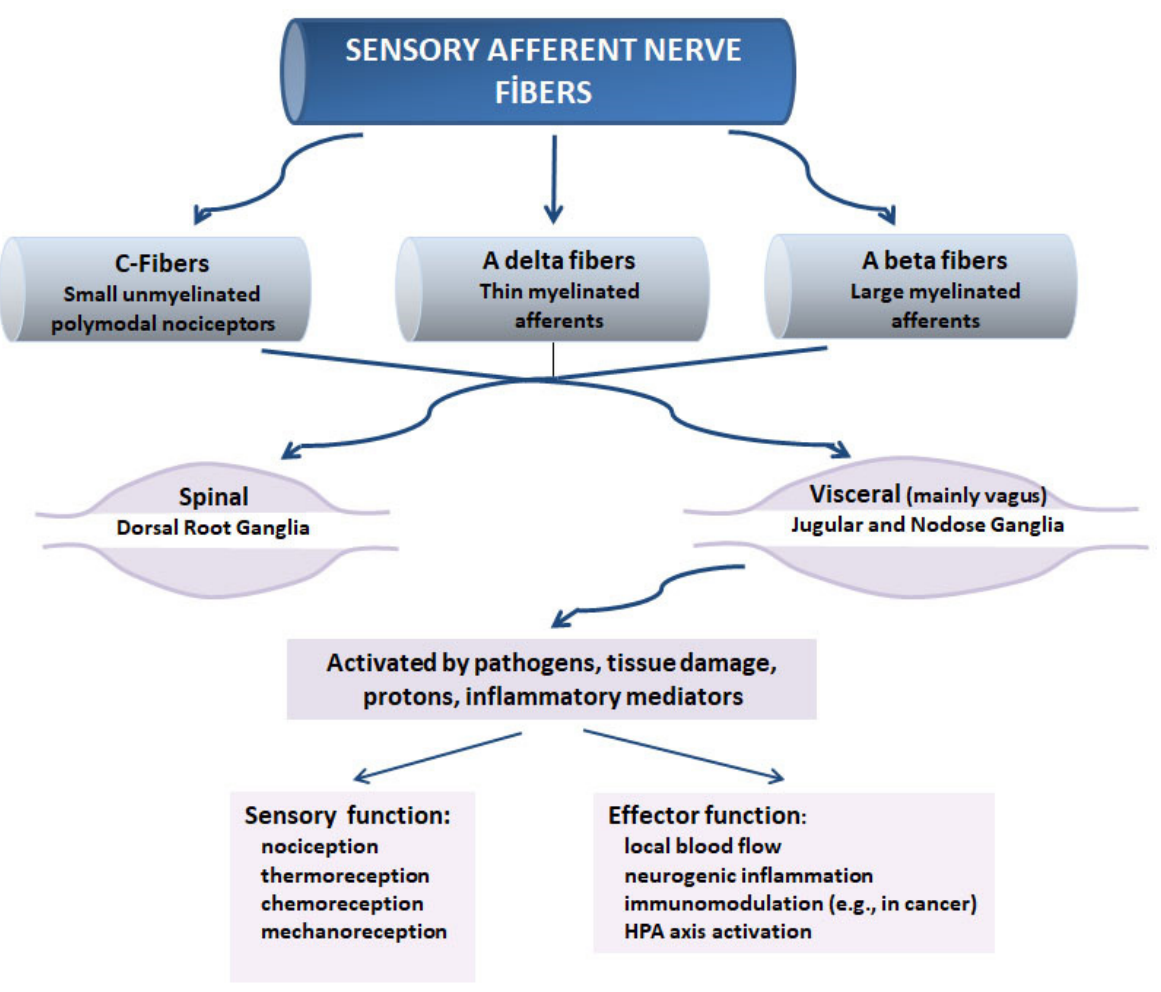
Figure 1. Anatomical and functional classification of sensory nerve